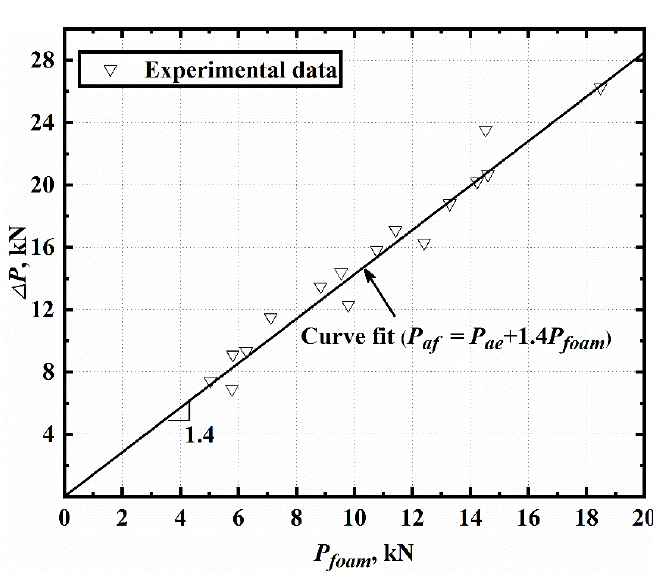
Figure 6. The strengthening load versus foam plateau load of aluminum foams.